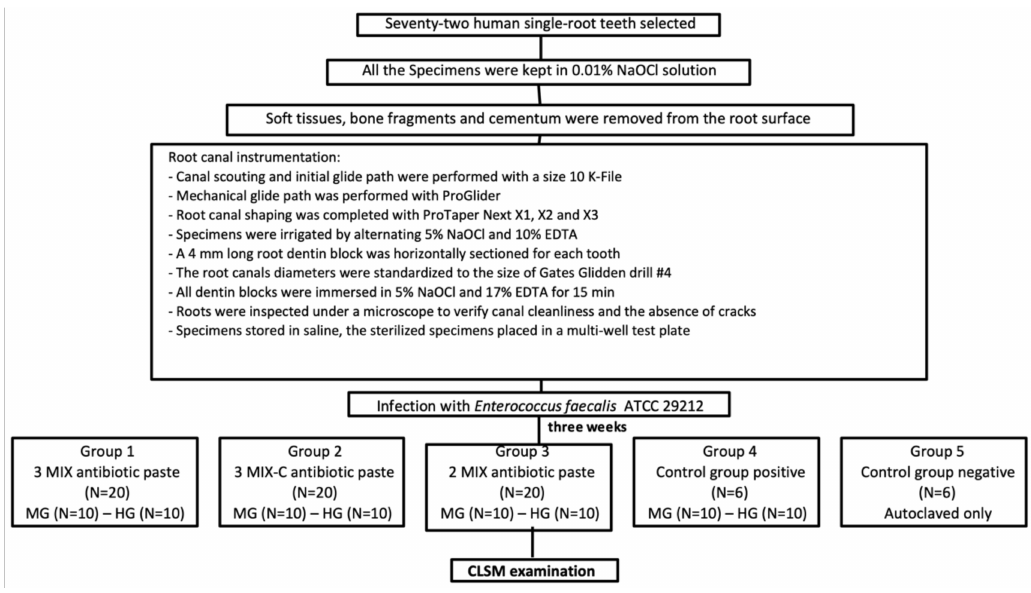
Figure 1. Flow diagram of the study design. 2-MIX, ciprofloxacin and metronidazole; 3-MIX ciprofloxacin, metronidazole and minocycline; 3-MIXC, ciprofloxacin, metronidazole and clarithromycin; HA, hyaluronic acid; MG, macrogol